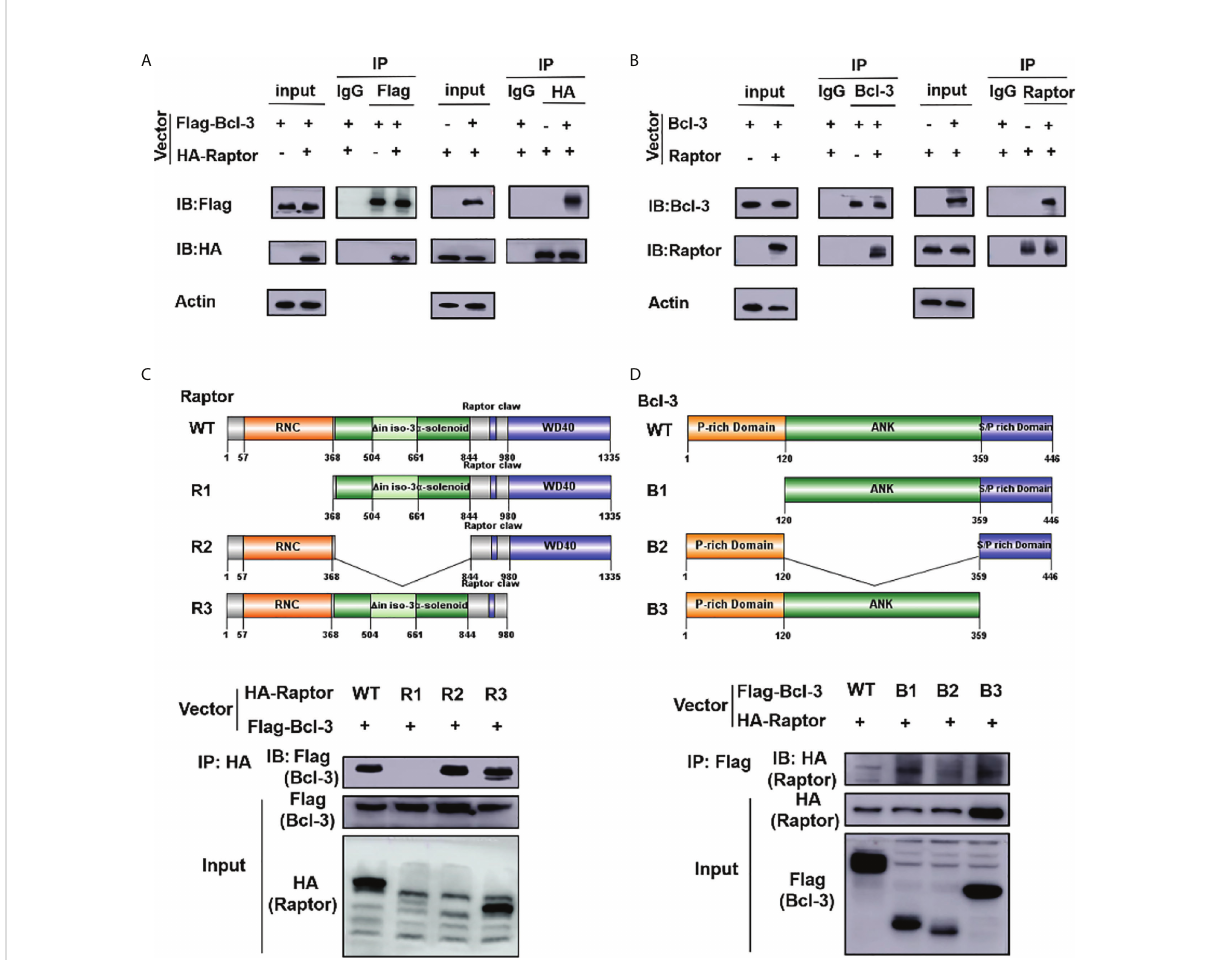
FIGURE 7 Bcl-3 interact with Raptor. (A) Flag-Bcl-3 interacted with HA-Raptor in 293T cells. The cells were co-transfected with Flag-Bcl-3 and HA-Raptor plasmids for co-IP assays using the anti-Flag and anti-HA antibodies, respectively. (B) Endogenous Bcl-3 interacted with endogenous Raptor in 293T cells detected by co-IP assays. (C) RNC domain of Raptor is needed for Raptor to interact with Bcl-3. 293T cells were transduced with plasmids expressing WT or different deletion mutants of HA-Raptor together with Flag-Bcl-3 vector for co-IP assays. (D) The ID domain of ANK is required for Bcl-3 to interact with Raptor. 293T cells were transduced with vectors expressing WT or different deletion mutants of Flag-Bcl-3 vectors together with the HA-Raptor vector for co-IP assays. Data above are representative of 2 independent